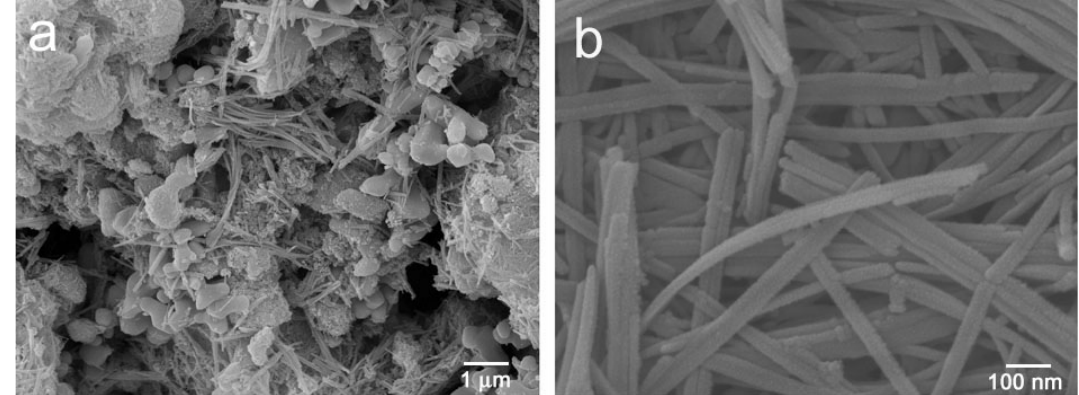
Fig. 2 SEM micrographs of the partially-nanowire structured TiO anatase nanowires and relatively large rutile particles. (a) low magnification, (b) high magnification for